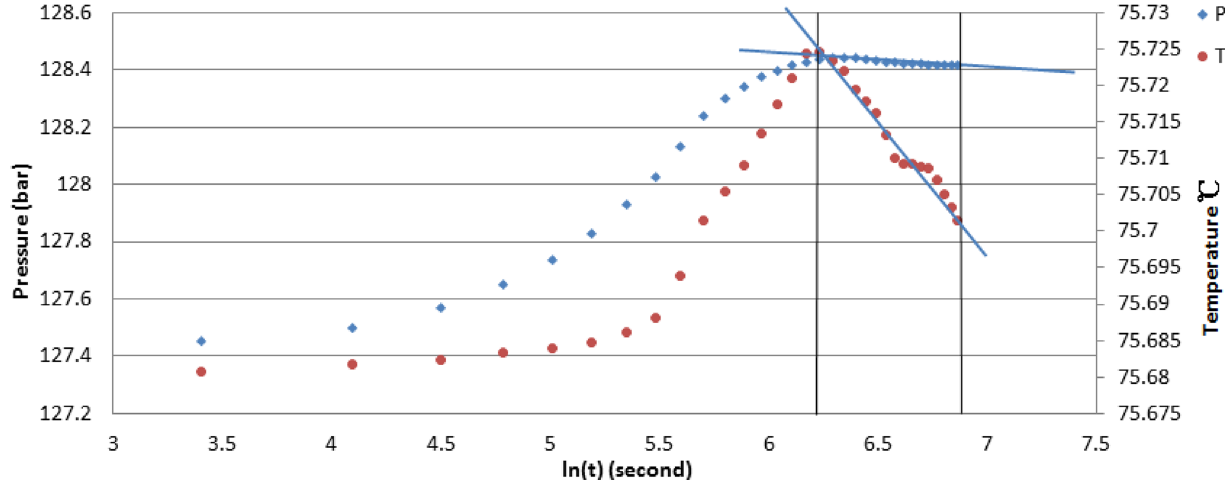
Fig. 18 TTA of transient III: ε ′ = dT / dP = 0.023/0.04 = 0.575